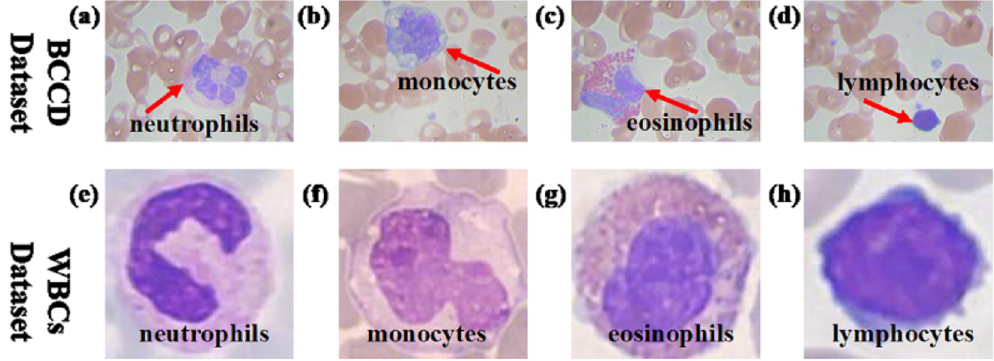
Fig 1. Sample images from BCCD (The first row) and the WBCs dataset (The second row). Among them, (a) and (e) are neutrophils, (b) and (f) are monocytes, (c) and (g) are eosinophils, and (d) and (h) are lymphocytes.